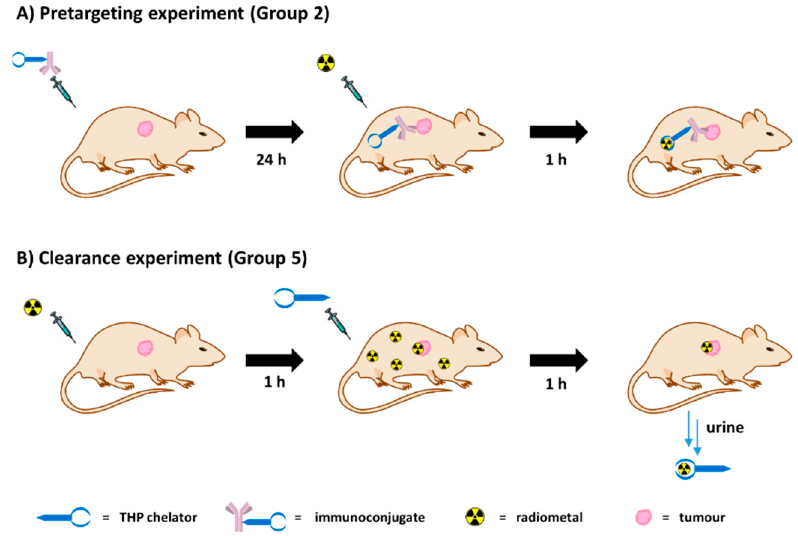
Figure 2. Schematic representation of the experimental workflow for the reported pretargeting experiment ( A ) and clearance experiment ( B ) using 68 Ga and THP Me chelators.